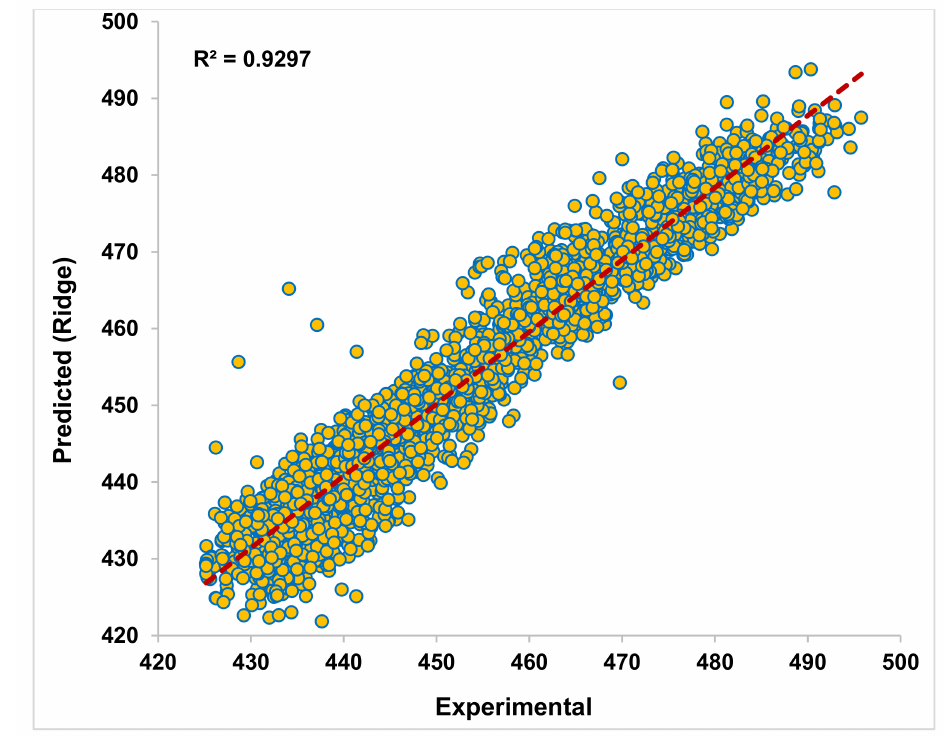
Figure 4. Ridge regressor ( α = 0) predicting the PEO with R 2 = 0.9297 during